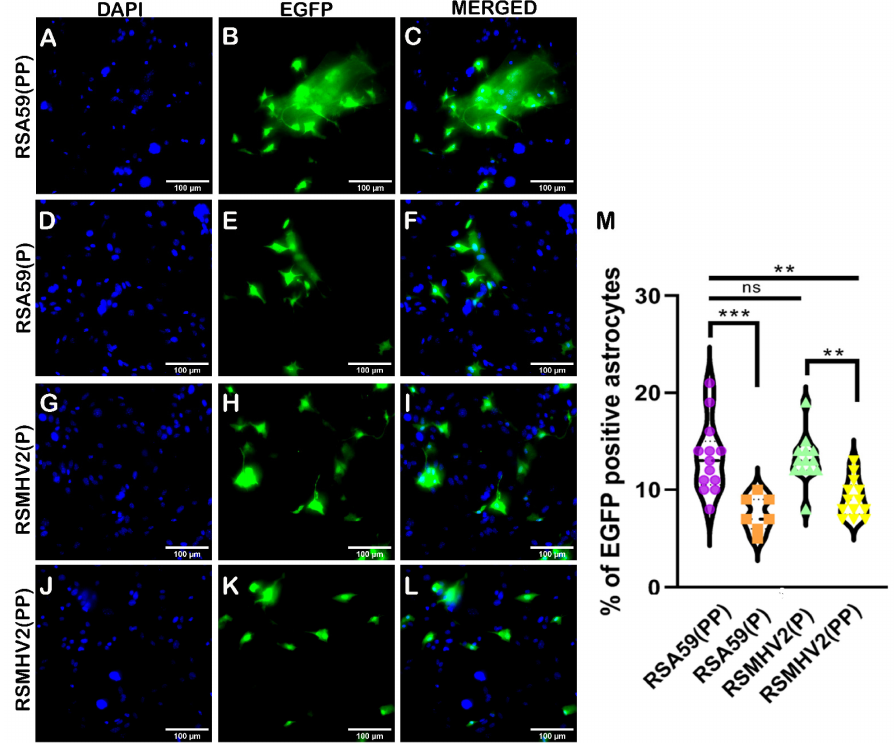
Figure 5. Infection of primary astrocyte cultures with parental strains RSA59(PP), RSMHV2(P), one proline deleted RSA59(P), and one proline added RSMHV2(PP) mutants. Primary astrocyte cultures were infected with RSA59(PP) ( A – C ), RSA59(P) ( D – F ), RSMHV2(P) ( G – I ), and RSMHV2(PP) ( J – L ) at MOI 2 and counterstained with DAPI at 24 h p.i. Merged images of EGFP and DAPI channels presented show infected cells and their nuclei ( C , F , I , L ). The percentage of EGFP-positive cells in RSA59(PP), RSA59(P), RSMHV2(P), and RSMHV2(PP) infected cultures were quantified and plotted in a violin diagram ( M ). Experiments were performed three times in triplicate per strain (N = 9). The level of significance was taken at p < 0.05 following One-way ANOVA analysis. ** p < 0.001, *** p < 0.0001, and ns denotes